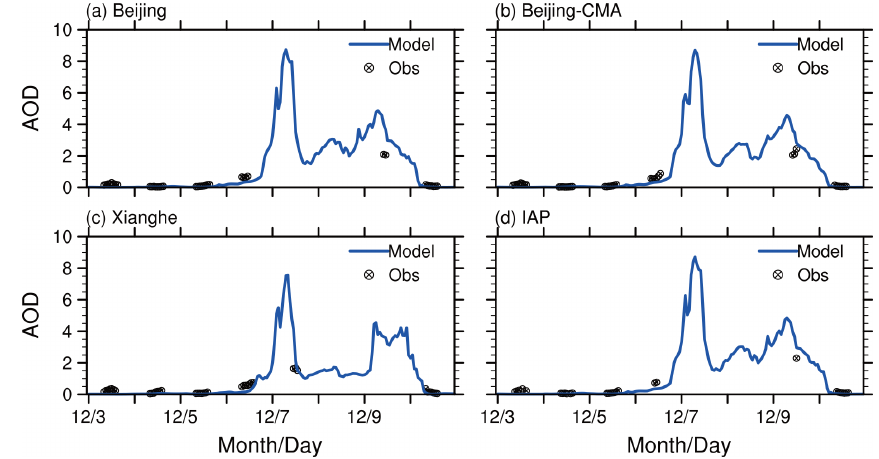
Figure 4. Temporal variation of observed (black dots) and simulated (blue) AOD at 550nm during 3–10 December (LT) at (a) Beijing, (b) Beijing-CMA, (c) Xianghe and (d) IAP. AOD observations are from (a–c) AERONET and (d) the IAP in situ site.